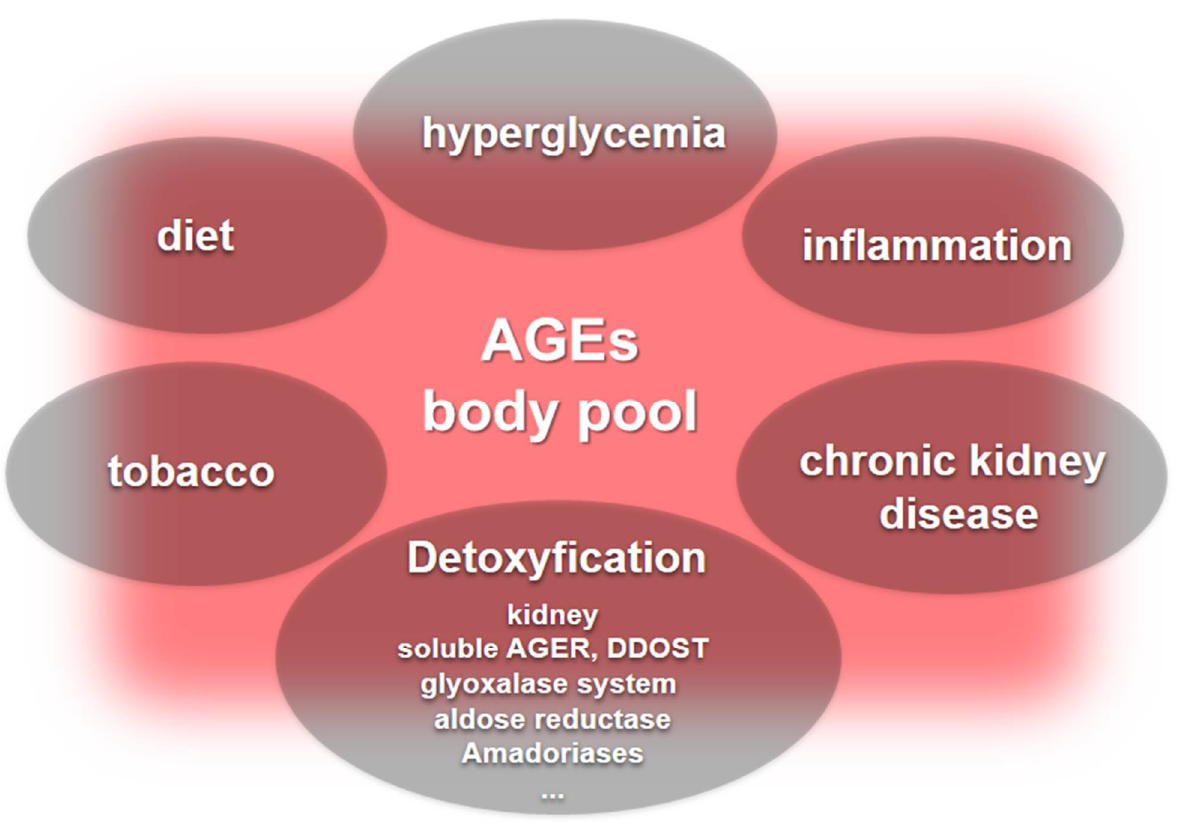
Figure 3. The body pool of AGEs. Hyperglycemia, inflammation, and chronic kidney disease are major contributors to the body’s pool of AGEs. Furthermore, dietary sources of AGEs and tobacco add to the AGE pool, while detoxification systems include kidney function and the role played by soluble AGERs and DDOST that neutralize deleterious AGER signaling, along with enzyme systems, including the glyoxalase system, aldose reductase, and the lesser-known amadoriases.